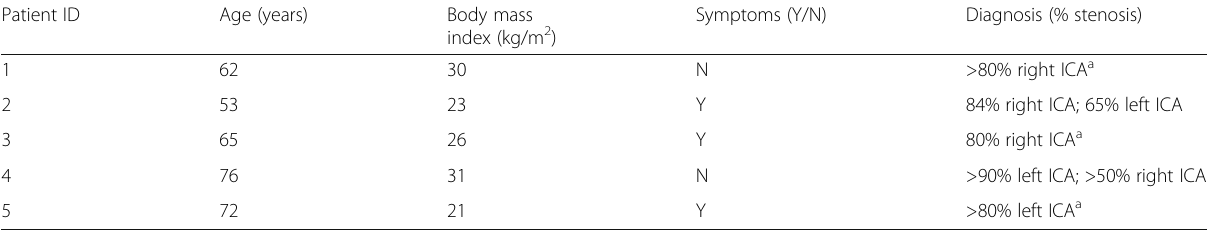
Table 1 Patient characteristics, including neurological symptoms and % stenosis, as measured by magnetic resonance imaging (MRI) Patient ID